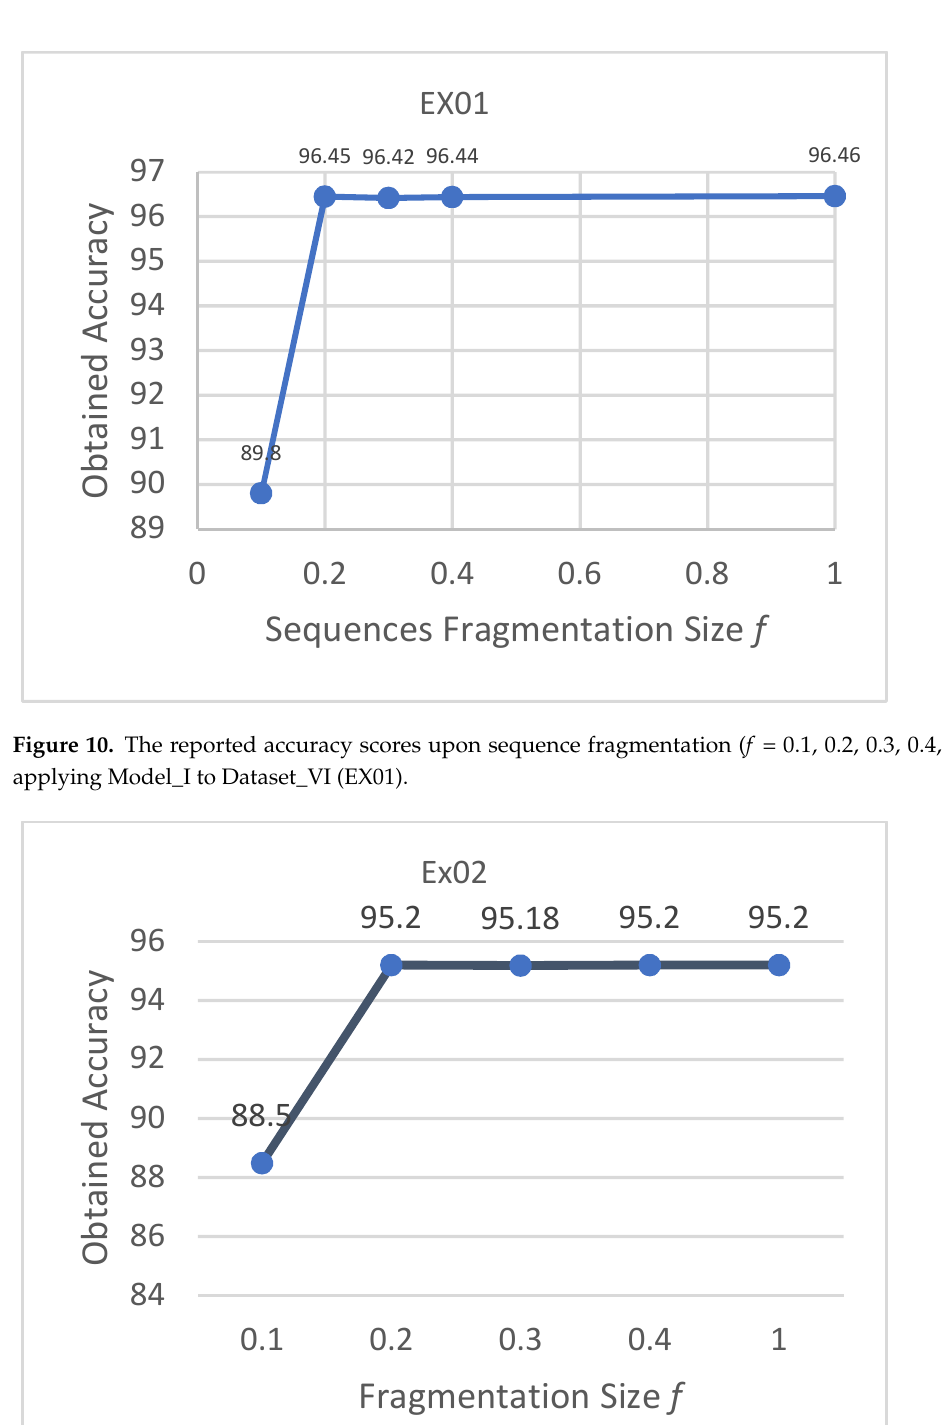
Figure 9. Examining each sub-dataset (DS n ) and determining the biomarker detection accuracy of each sub-dataset. Fragmentation size f = {0.1, 0.2, 0.3, and 0.4} were applied to determine which sub- dataset DS n has the highest accuracy scores of biomarker detection.